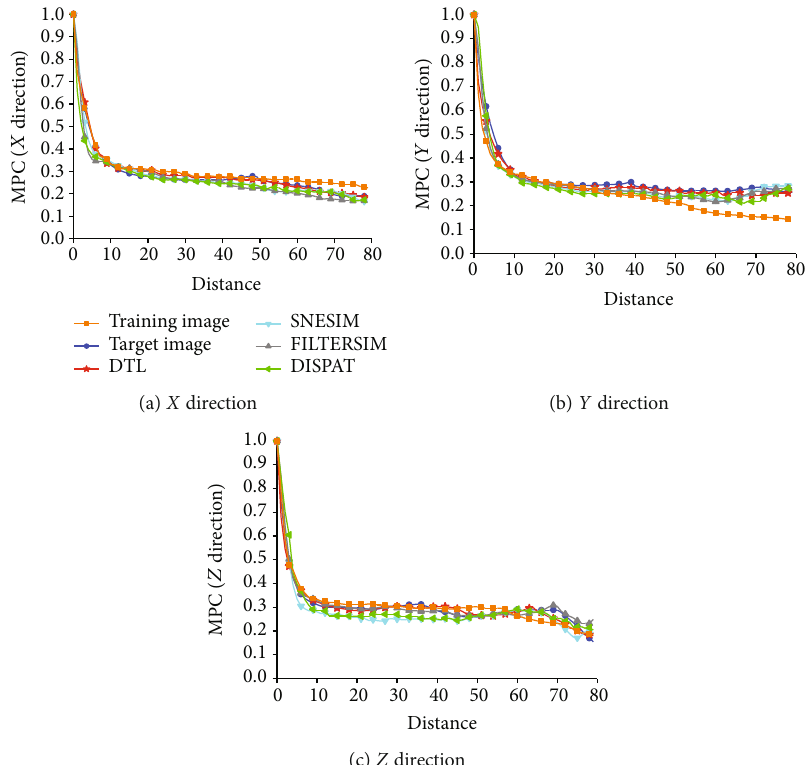
Figure 26: MPC curves of reconstructed shale images by 5% conditioning data using SNESIM, FILTERSIM, DISPAT, and DTL in three directions.